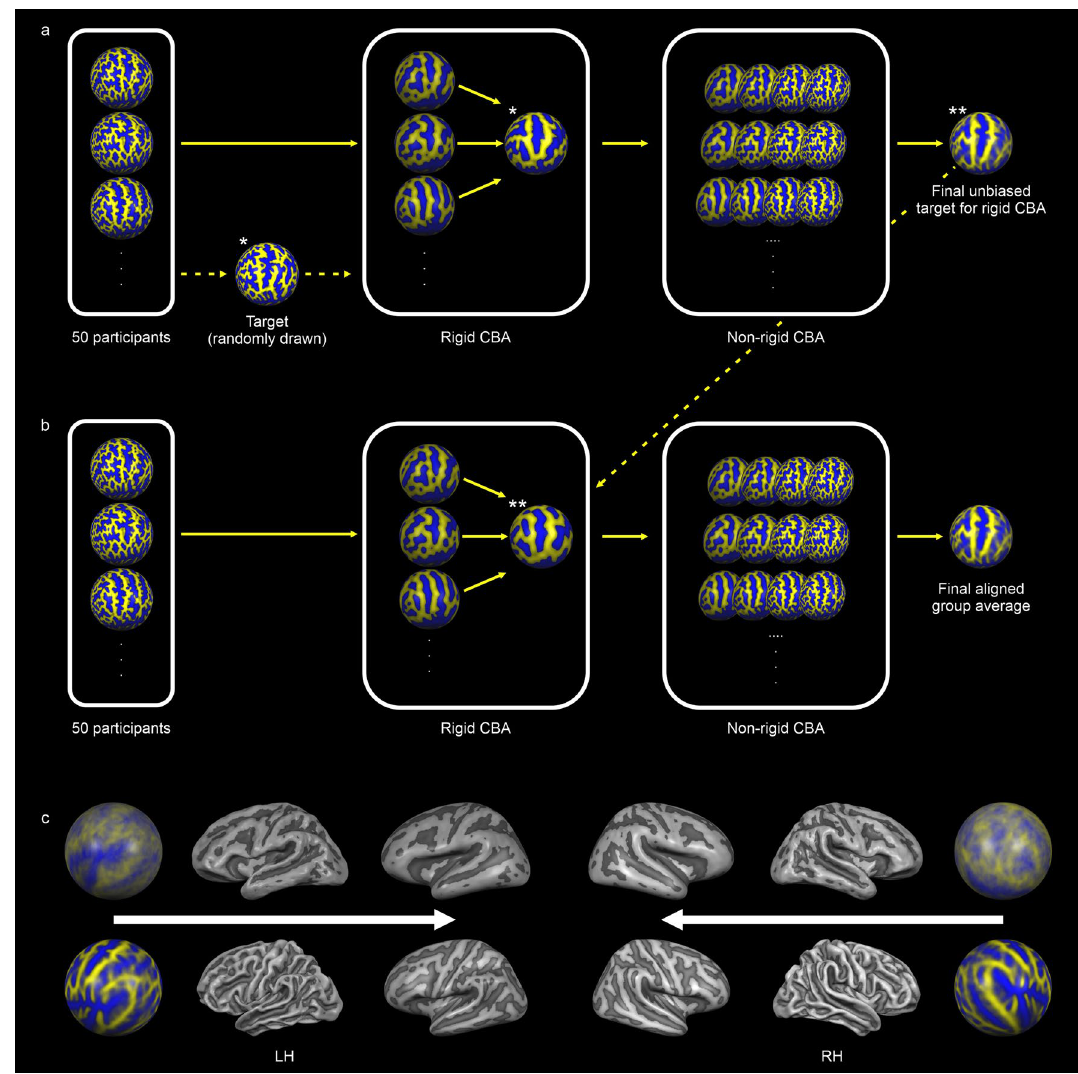
Figure 6. Fully data-driven CBA approach. CBA consisted of a rigid alignment to a single target brain and a non-linear alignment to an iteratively updated group average brain. ( a ) We carried out an initial CBA solely to generate an unbiased average target brain for the final CBA. We used a randomly selected brain from among all participants for the initial rigid CBA. ( b ) For the final CBA we used the unbiased average target brain created during the initial CBA for rigid CBA. ( c ) We generated average surface representations before and after macroanatomical alignment for each hemisphere, which we subsequently merged, inflated and used for analysis and visualization of the appropriate data sets. The upper row depicts group average spherical, folded and inflated mesh representations before applying CBA. The lower row depicts group average spherical, folded and inflated mesh representations after applying